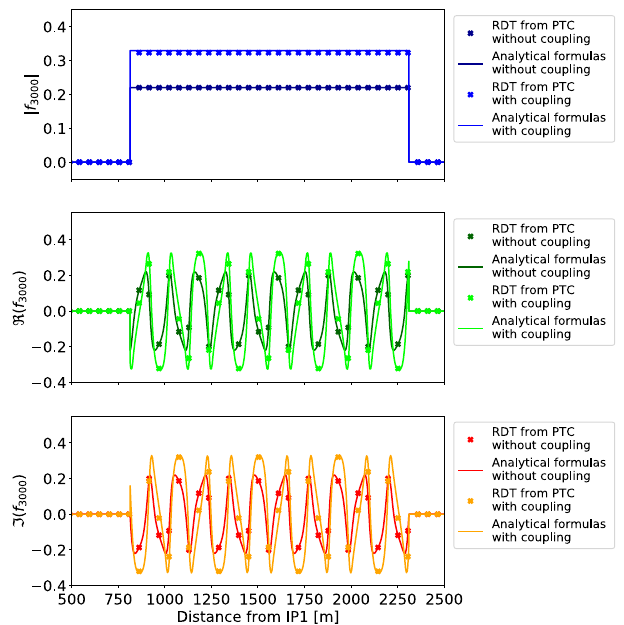
FIG. 6. Comparison for the sextupole RDT f 3000 between MAD-X-PTC and derived